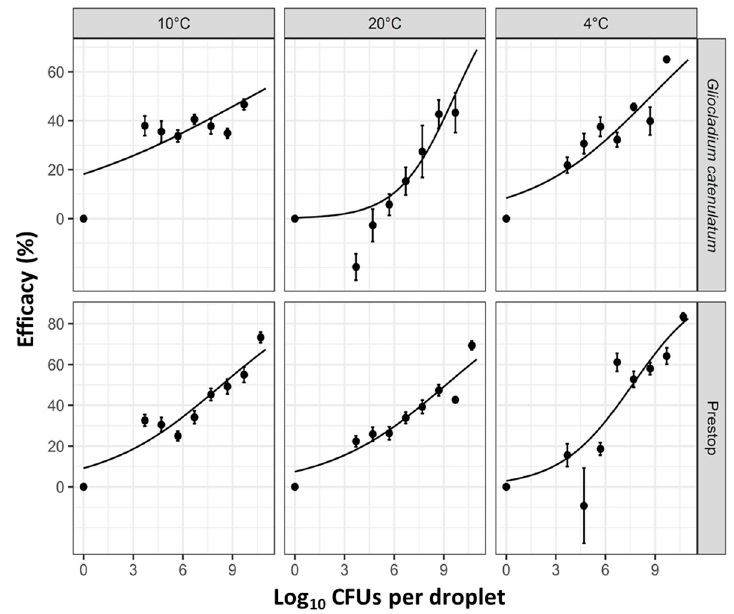
Figure 3. Efficacy from in vitro competition assays of G. catenulatum and Prestop at tested inoculum doses inhibiting growth of a B. cinerea mycelial plug at 4, 10 and 20 ◦ C; the bars represent one standard error and the curve is a fitted logistic model.